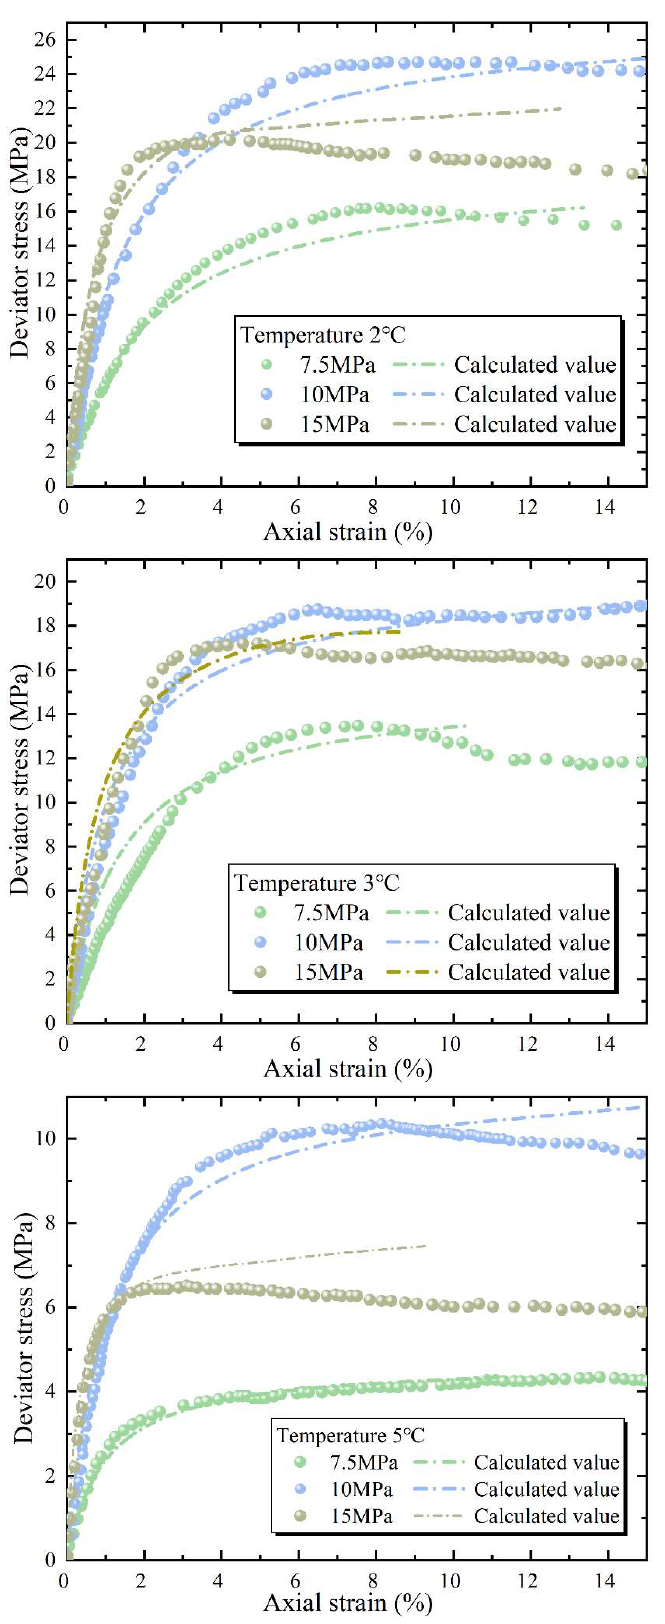
Figure 16. Experimental comparison with calculated stress–strain curves.